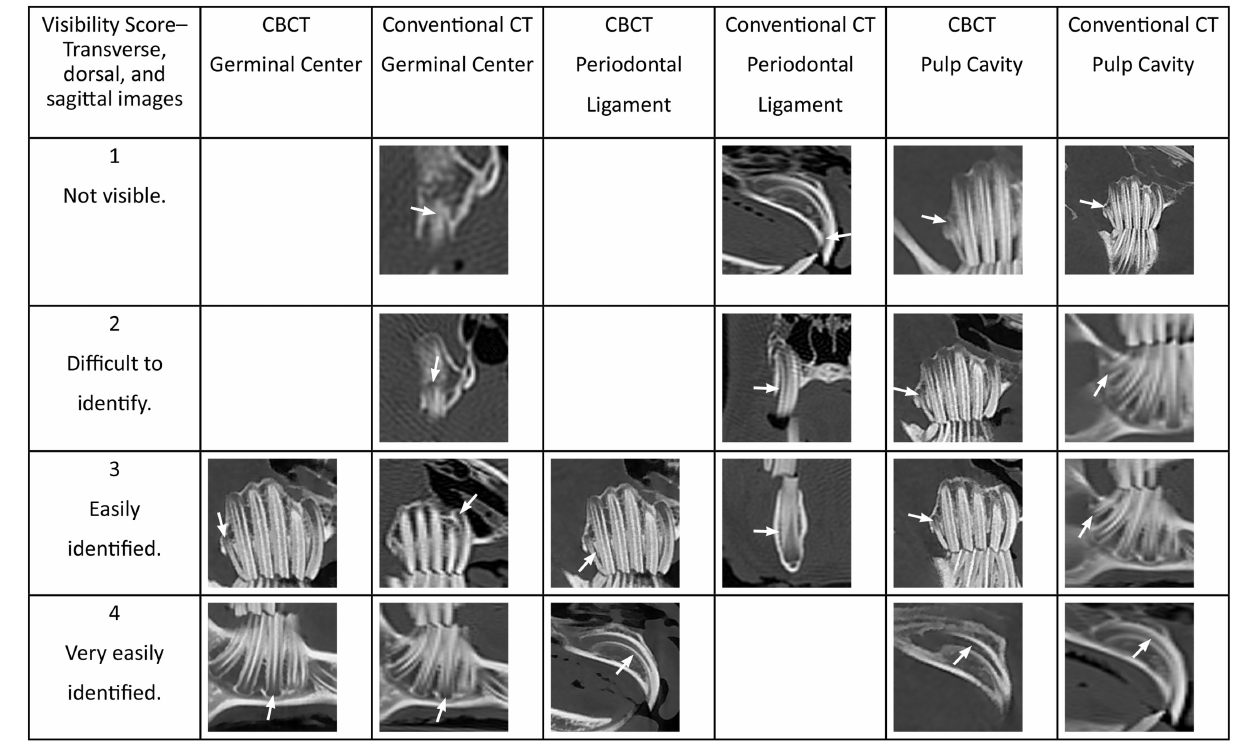
FigUre 5 | The cBcT and conventional cT transverse, dorsal, sagittal, and custom MPr images displaying the various scores for germinal center, pulp cavity, and periodontal ligament visibility . The white arrows indicate the tooth and structure given the score. Blank boxes indicate that no teeth met these